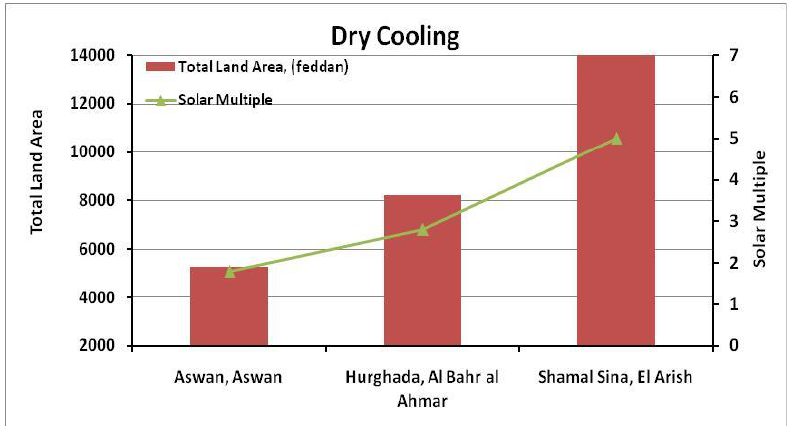
Fig. 4. Total land area required for three cities with